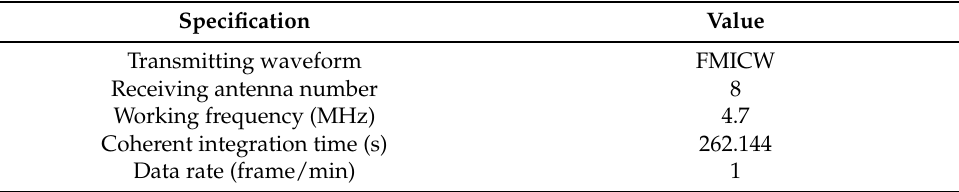
Table 1. The system parameters of CORMS.